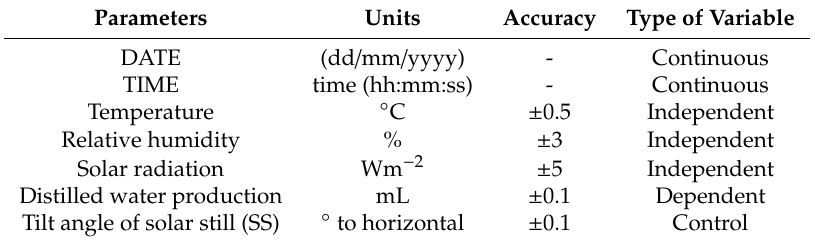
Table 1. Units and accuracy for each experimental parameter. Accuracy was derived from equipment